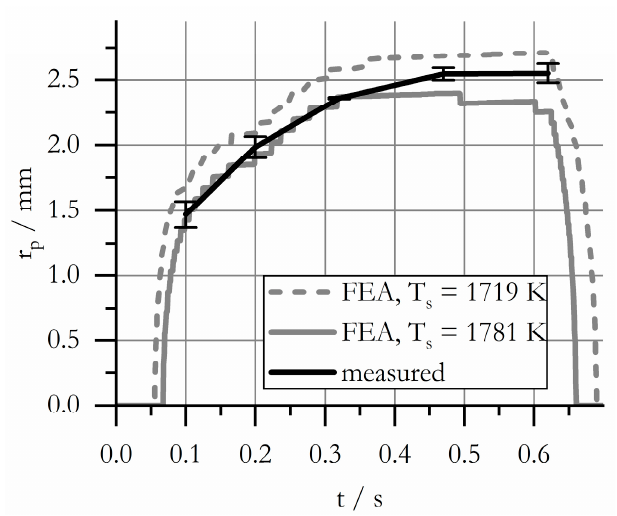
Figure 15. Nugget growth curve during the weld, measured and computed data.